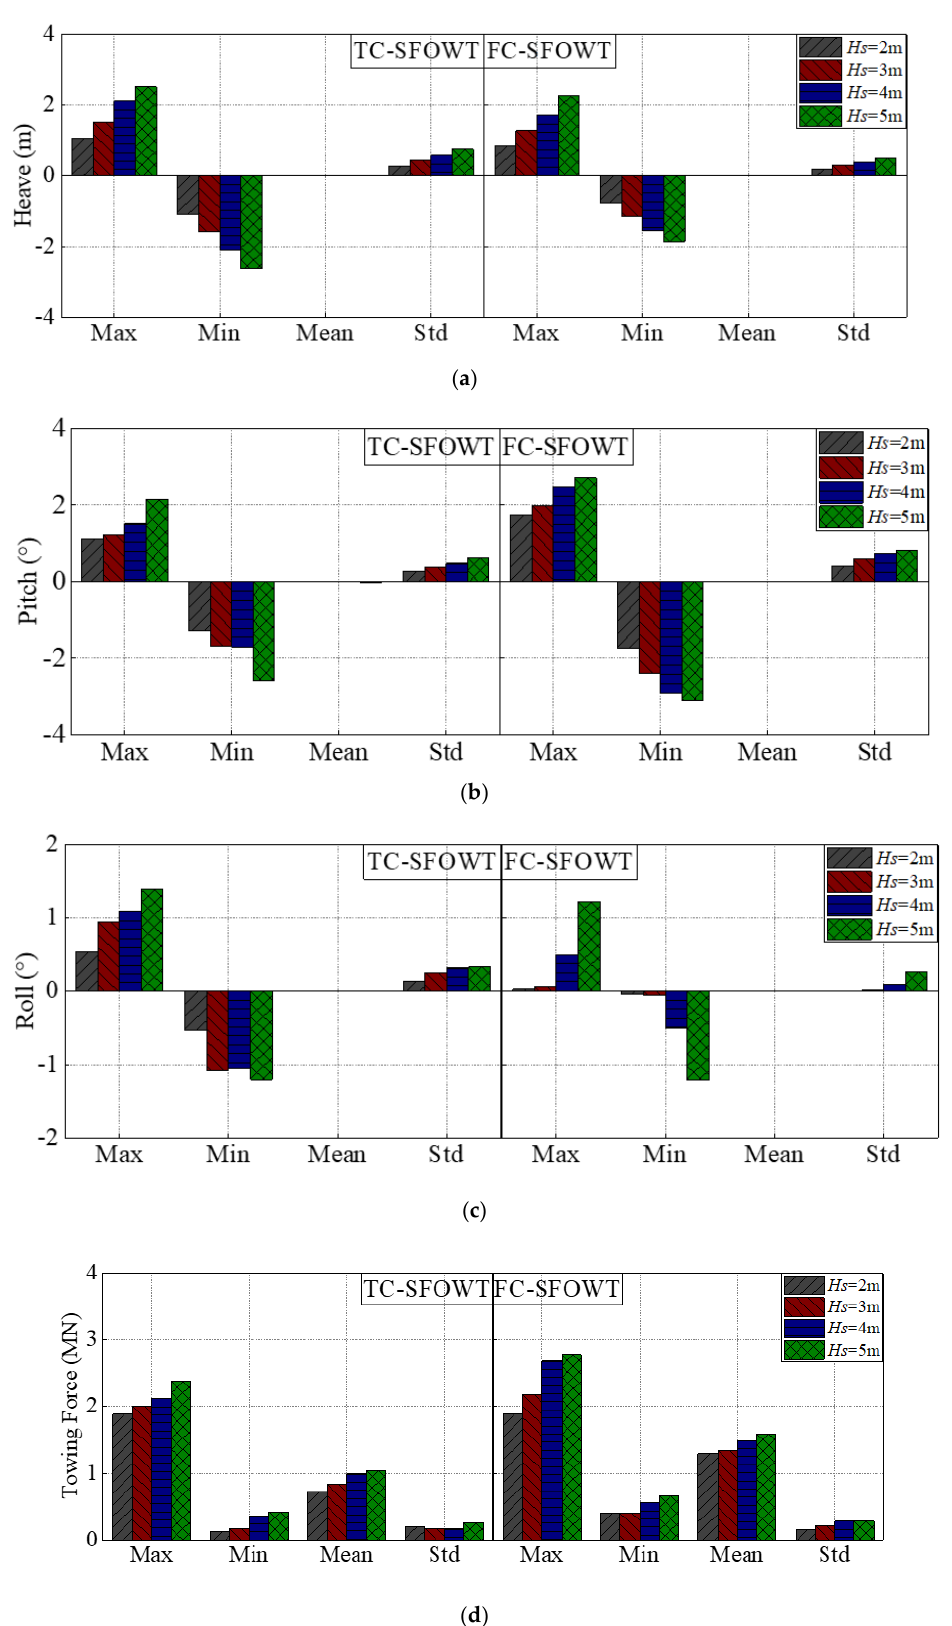
Figure 13. Statistics of the SFOWTs under different wave height conditions ( Tp = 8.9). ( a ) Heave motion, ( b ) pitch motion, ( c ) roll motion, ( d ) towing force.